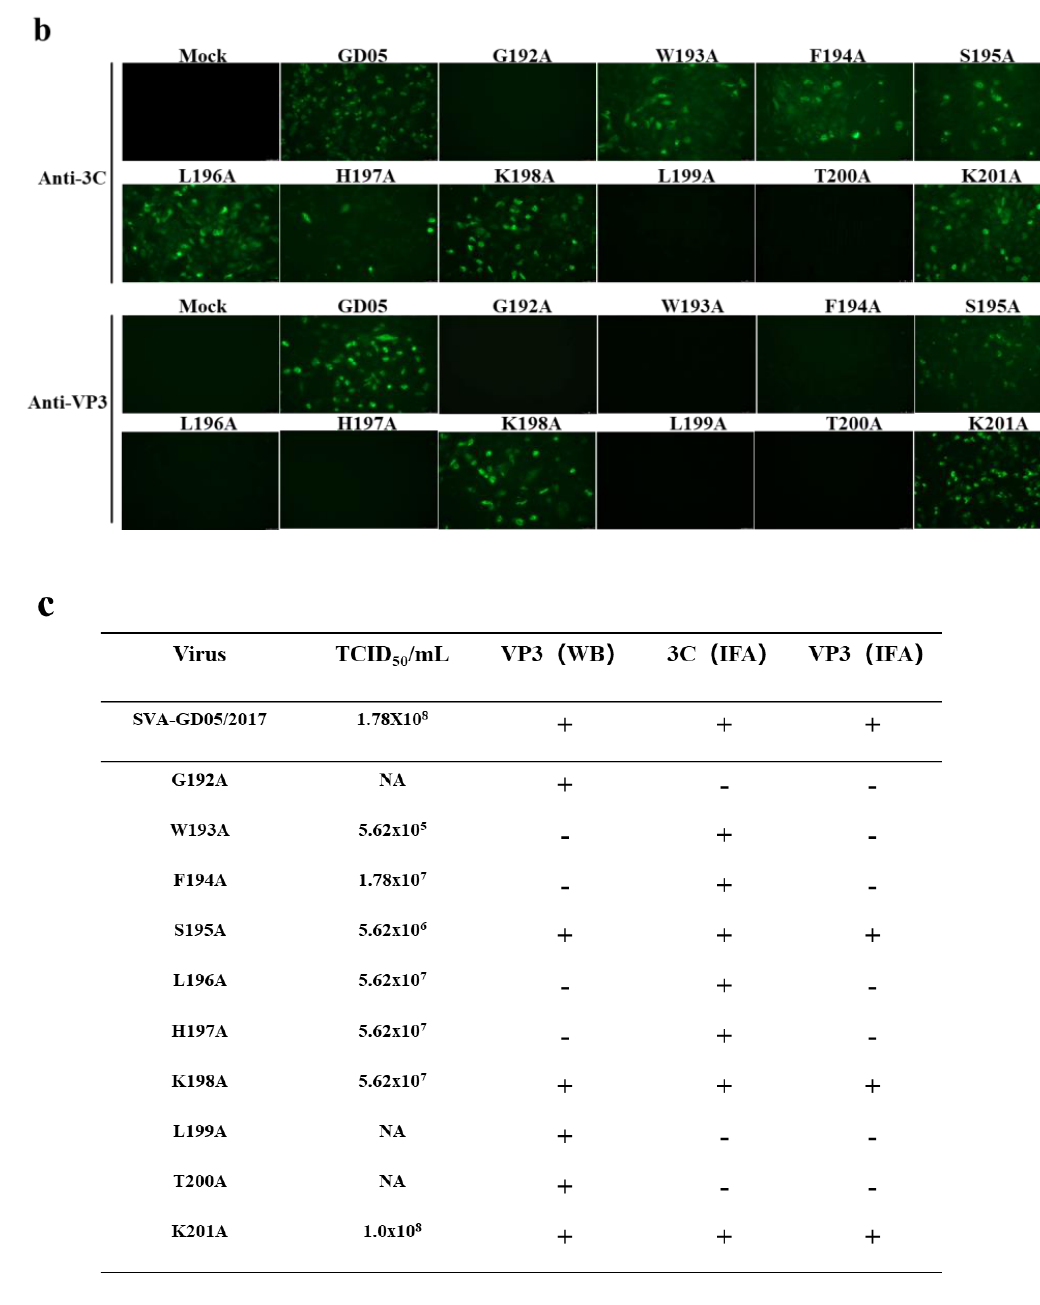
Figure 8. Alanine-scanning mutagenesis. ( a ) Alanine-scanning mutagenesis to determine the critical amino acids of the VP3 epitope 192 GWFSLHKLTK 201 . ST-R cells were transfected with pCAGGS-3FLAG-VP3 mutants for 48 h and then immunoblotted with anti-FLAG and anti-VP3 mAbs M: marker. ( b ) A group of pC3-SVA-GD05 plasmids was used to rescue the recombinant viruses, which were then propagated in the ST-R cells for three generations and analyzed by IFA using anti-VP3 mAbs. ( c ) Identification of SVA mutant viruses by virus rescue and immunological investigation with mAb 3E9. ‘NA’ means not available, ‘+’ means positive, ‘-’ means